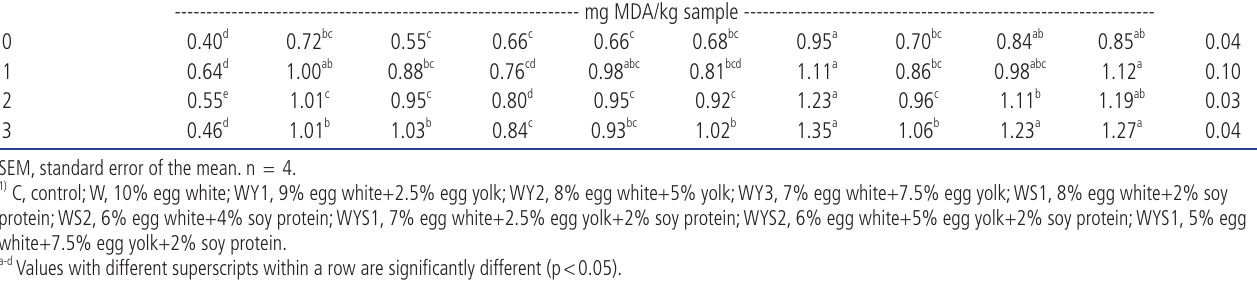
Table 5. The TBARS values of non-dairy creamers with different formula and storage time Storage